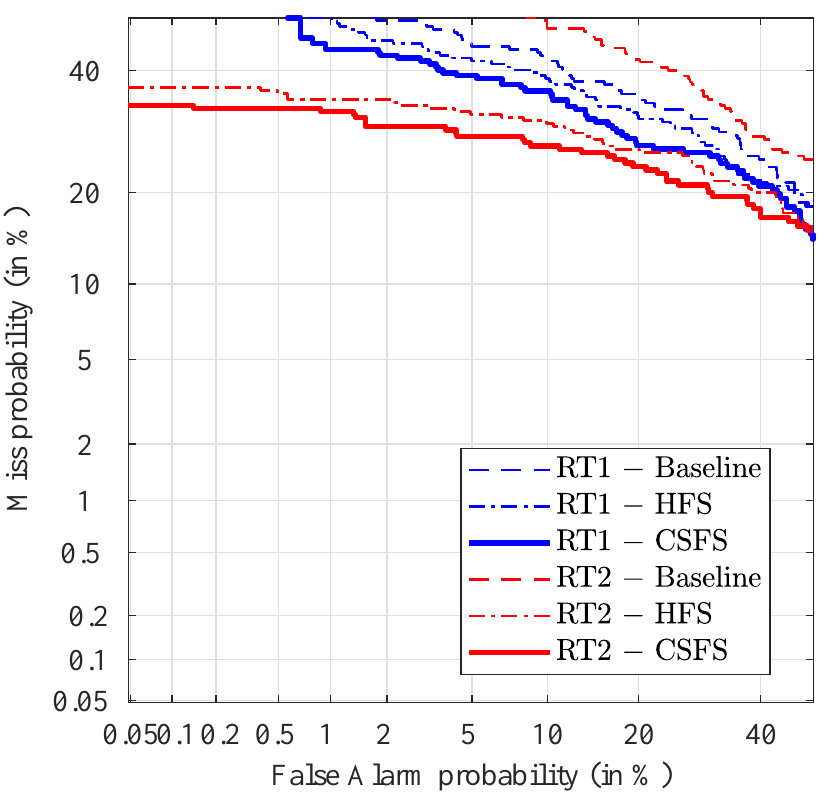
Figure 12. DET plots for stabilized